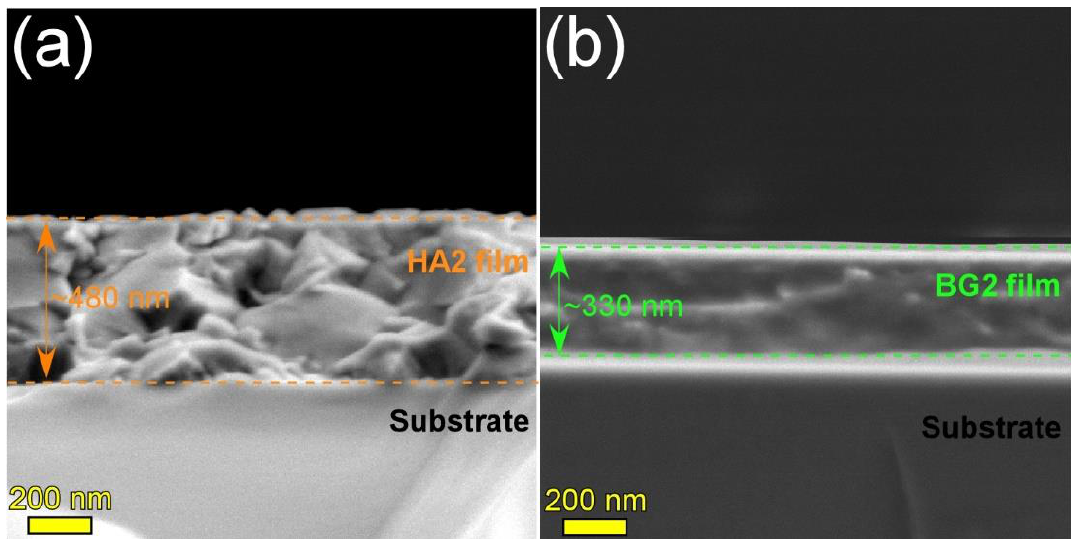
Figure 1. Cross-sectional SEM images of the ( a ) HA2 (post-deposition heat-treated at 500 °C/1 h in air) and ( b ) BG2 (as-sputtered) films deposited onto Si substrates.